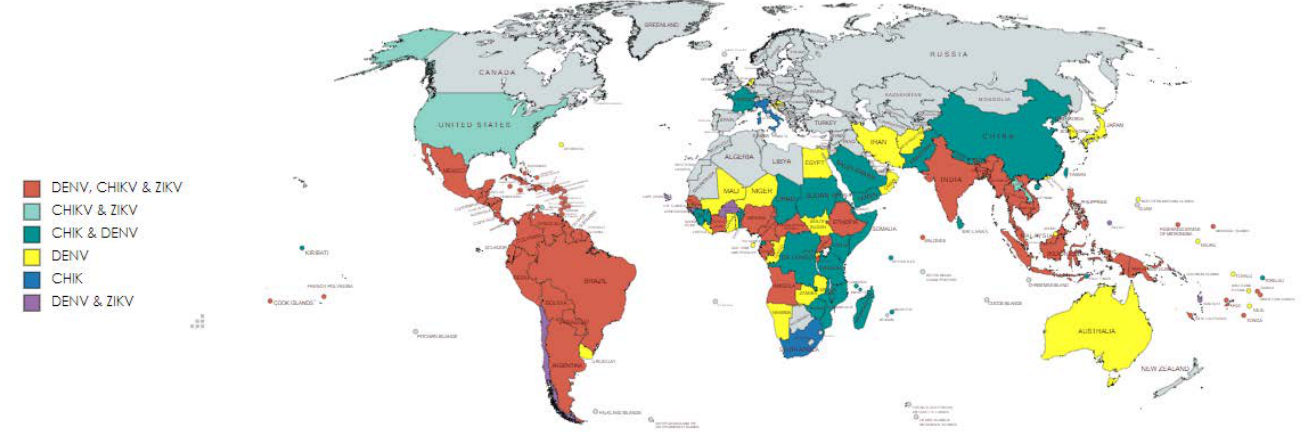
Figure 1. Global distribution of CHIKV, DENV and ZIKV infections. This map shows the global transmission of CHIKV, DENV and ZIKV. The map was created using the free online tool (https://mapchart.net/detworld.html; accessed on 17 December 2021) and inspired by [2]. The figure was created based on the data provide be following websites (accessed on 17 December 2021): https://www.cdc.gov/dengue/areaswithrisk/around-the-world.html; https://www.gov.uk/guidance/zika-virus-country-specific-risk#atoz; https://www.cdc.gov/chikungunya/geo/index.html.